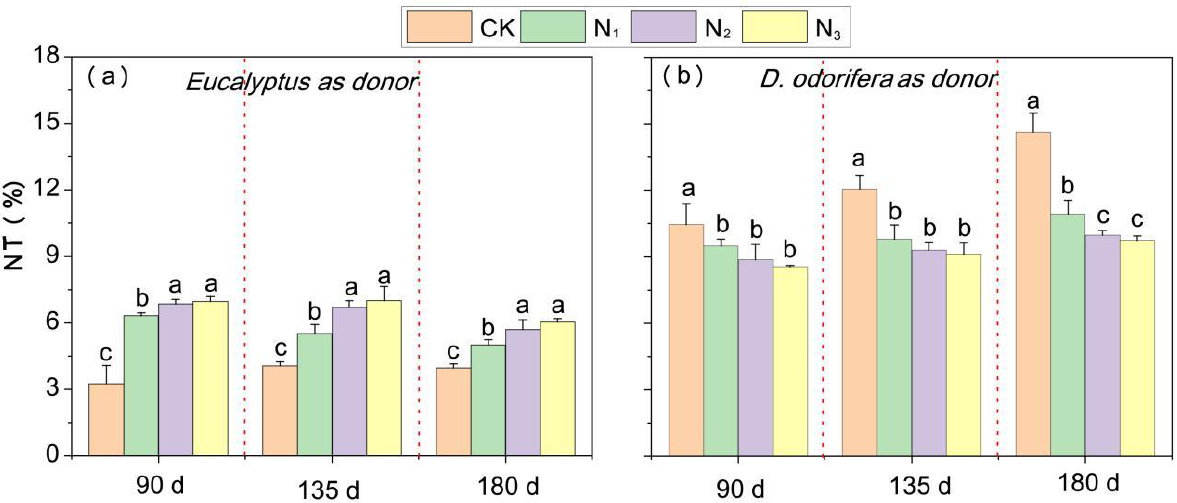
Figure 6. The bidirectional N transfer between D. odorifera and E. urophylla × grandis in an intercropping system with different percentages of N transfer (% NT) from N fertilizer application: ( a ) E. urophylla × grandis as the 15 N donor (i.e., % NT is the unidirectional transfer from E. urophylla × grandis to D. odorifera ); ( b ) D. odorifera as the 15 N donor (i.e., % NT is the unidirectional transfer from D. odorifera to E. urophylla × grandis ). CK indicates plants without N application, and N 1 , N 2 , and N 3 correspond to N fertilizer application rates of 3, 6, and 12 g urea (CO( 14 NH 2 ) 2 ) pot −1 , respectively. P N×T indicates the N level × time interaction. The different lowercase letters above the bars indicate significant differences ( p < 0.05) in N transfer percentage among the N treatments. Error bars indicate ± SE ( n = 4).